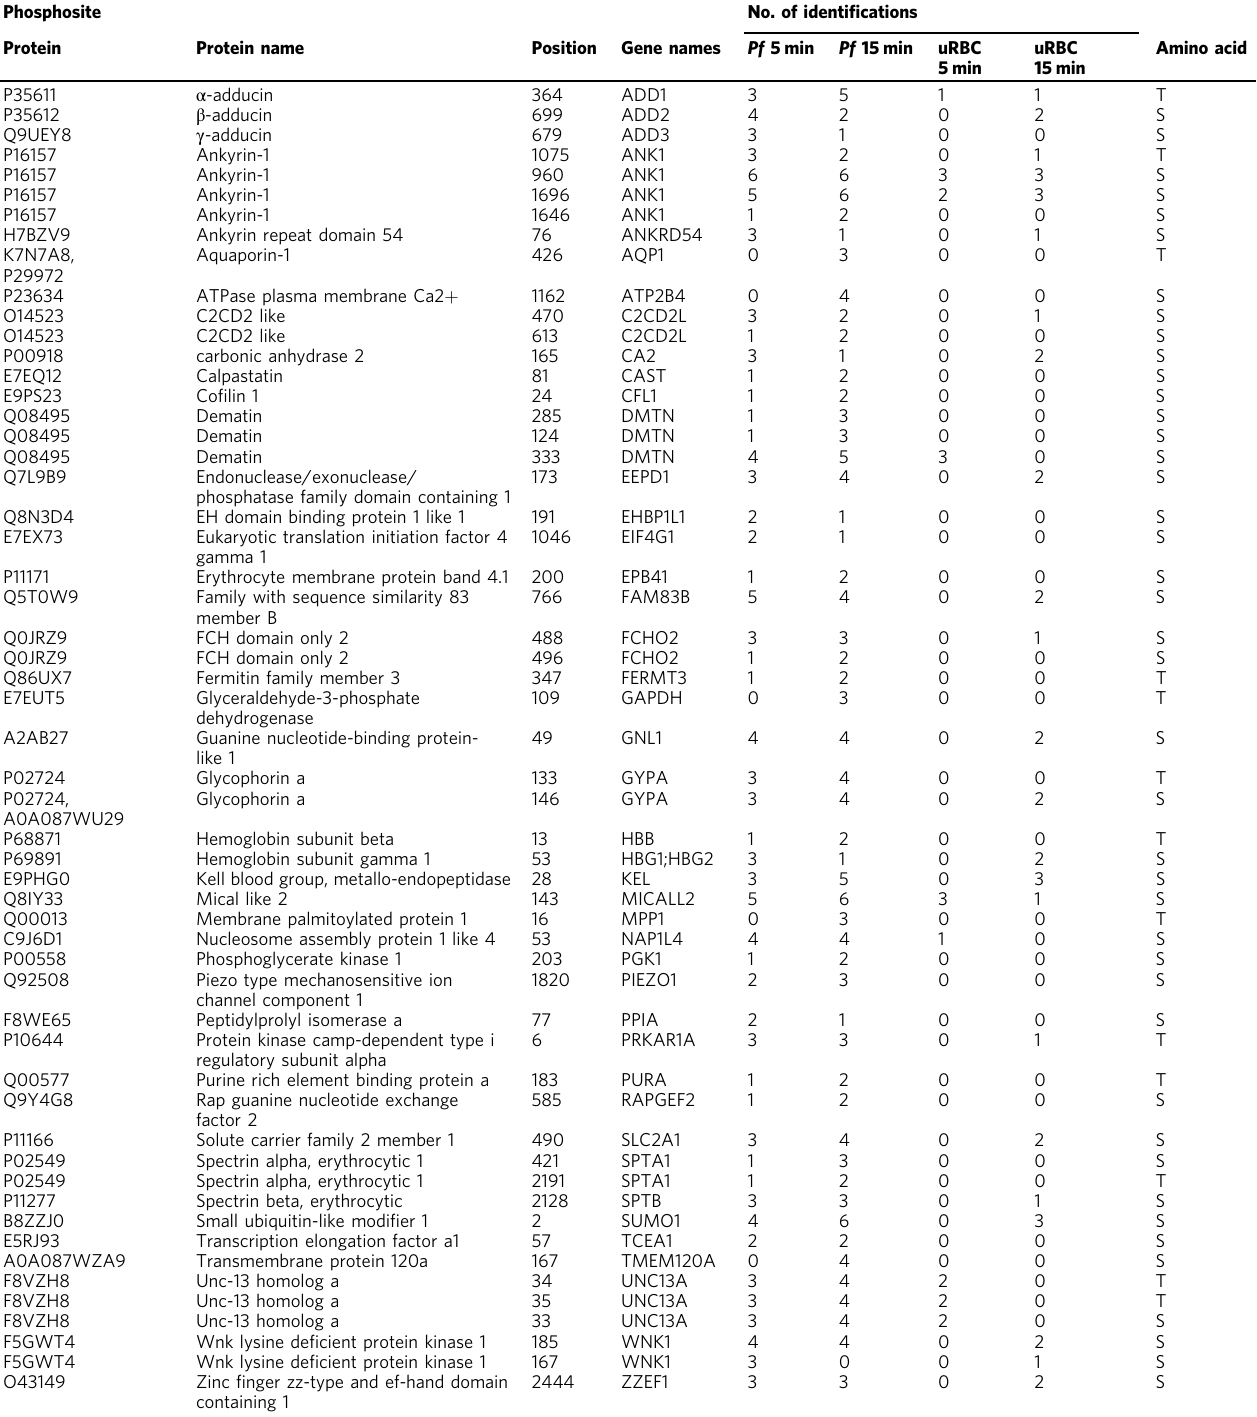
Table 1 Phosphosites that were enriched following Pf-derived EV treatment.